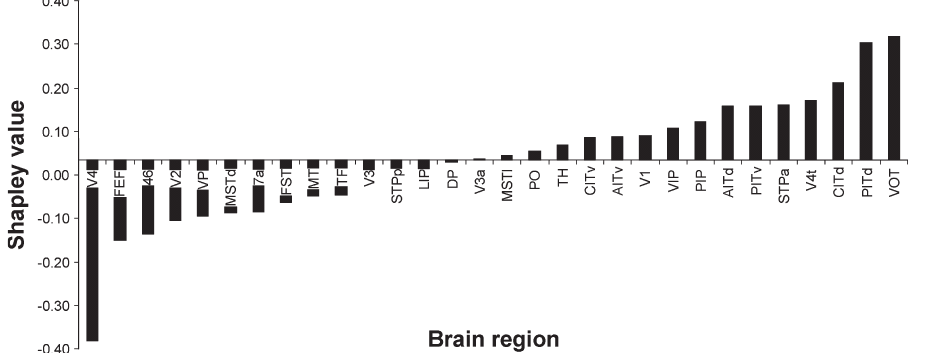
Figure 2. Shapley values obtained for the Y92 matrix. The x-axis is located at the expected Shapley value for a 30-node network, which is 1/30 (cid:5) 0.033.